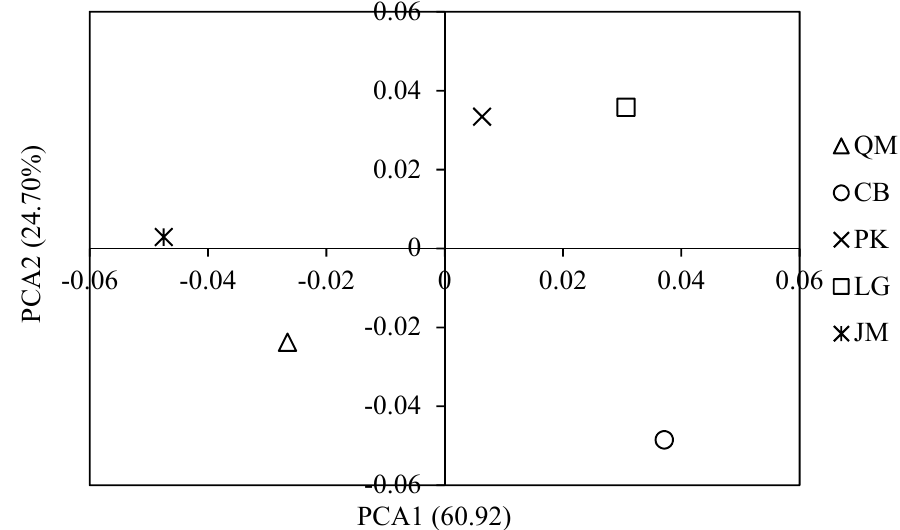
Figure 6. PCA plot of functional gene families based on KEGG database. LG: Larix gmelinii ; PK: Pinus koraiensis ; CB: Conifer-broadleaf forest; JM: Juglans mandshurica ; QM: Quercus mongolica.